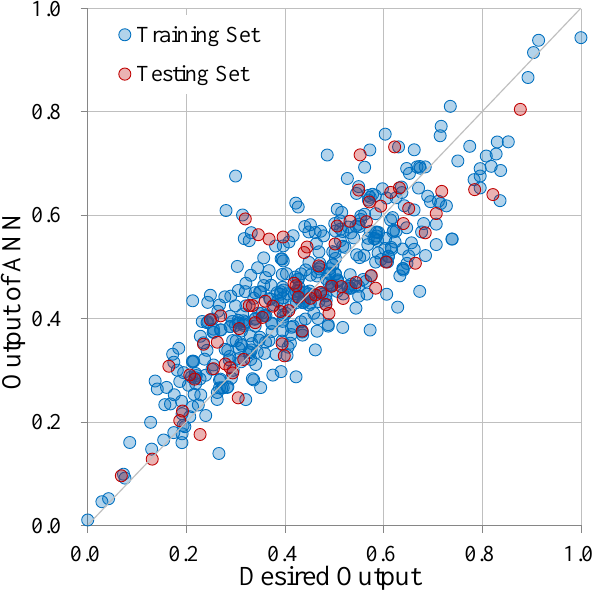
Figure 3. The comparison of the outputs of ANN with their target values in which the ANN has seven neurons in the hidden layer and is trained after 12,040 times of iteration.